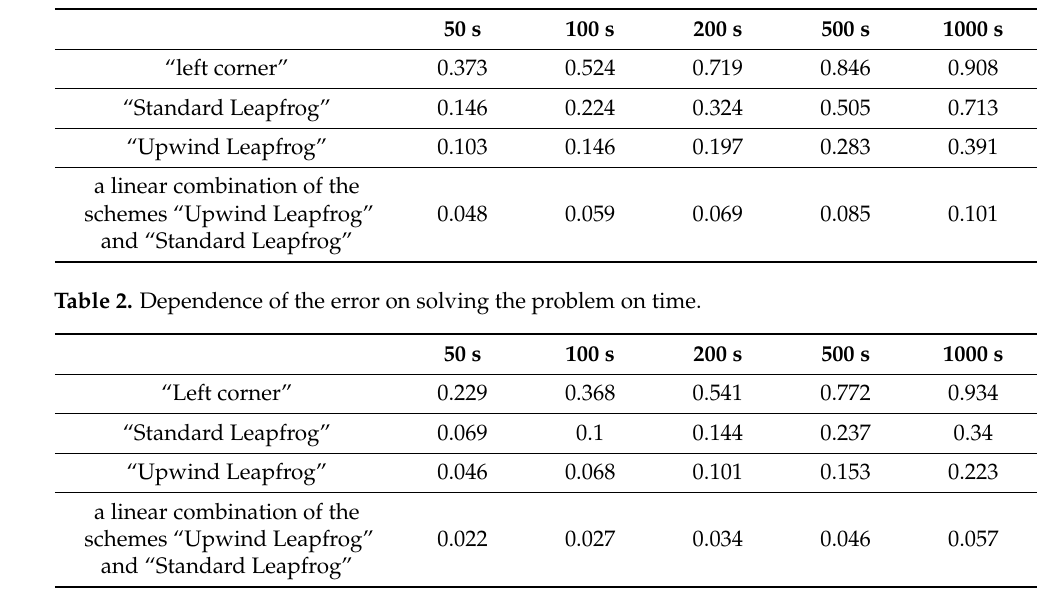
Table 1. The dependence of the error of solving the problem on time.